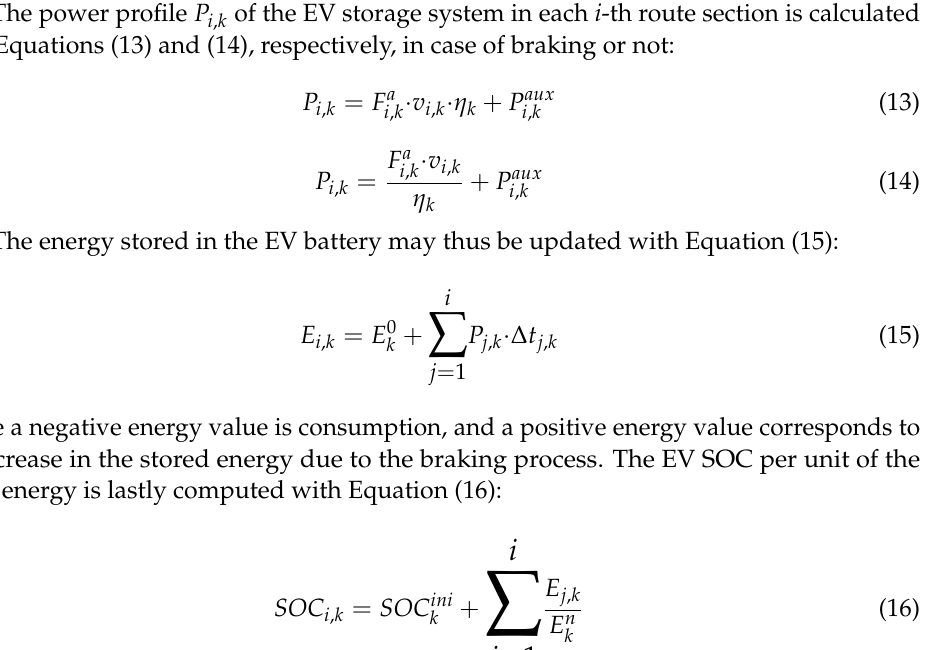
Figure 3. Clockwise, anticlockwise and round-trip solutions, obtained as combinations of all possible point-to-point routes, are analyzed with the same environmental, energetic and quality criteria listed above to obtain the best e-mobility service where interconnections between different departments must be